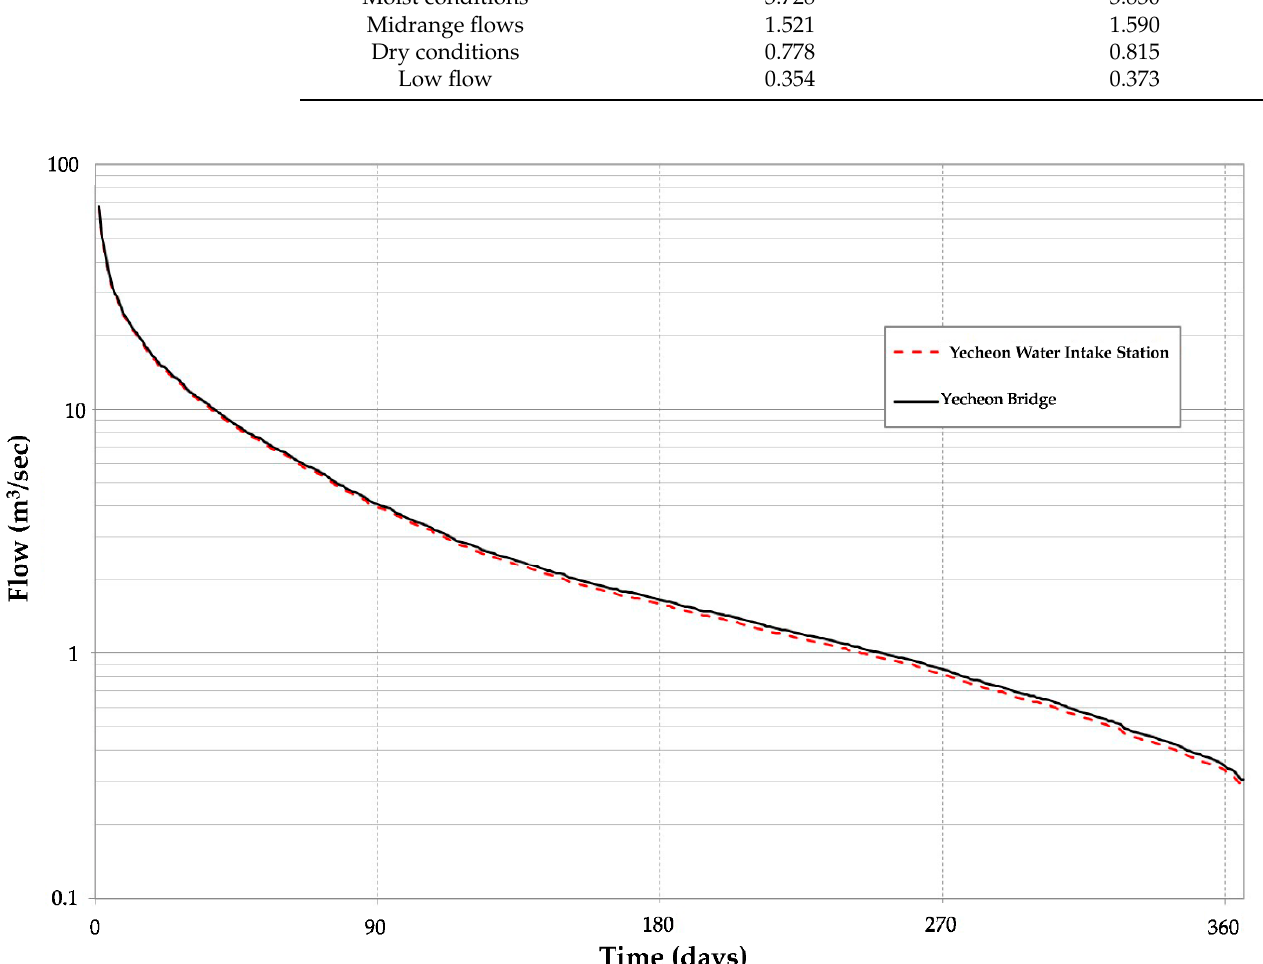
Table 5. Result of calculating the available number of water-intake days curve equation. Seasonal Classification